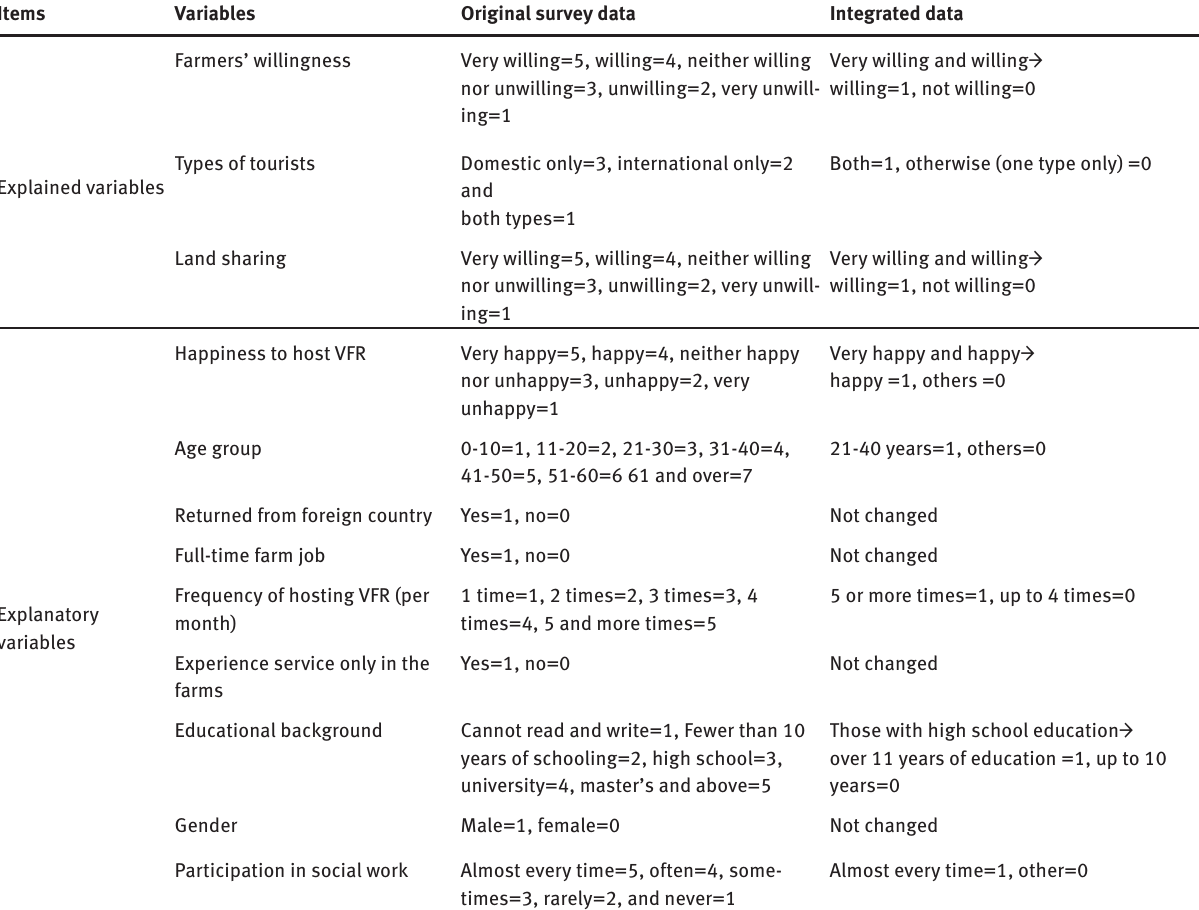
Table 4: Original survey and variable integration process